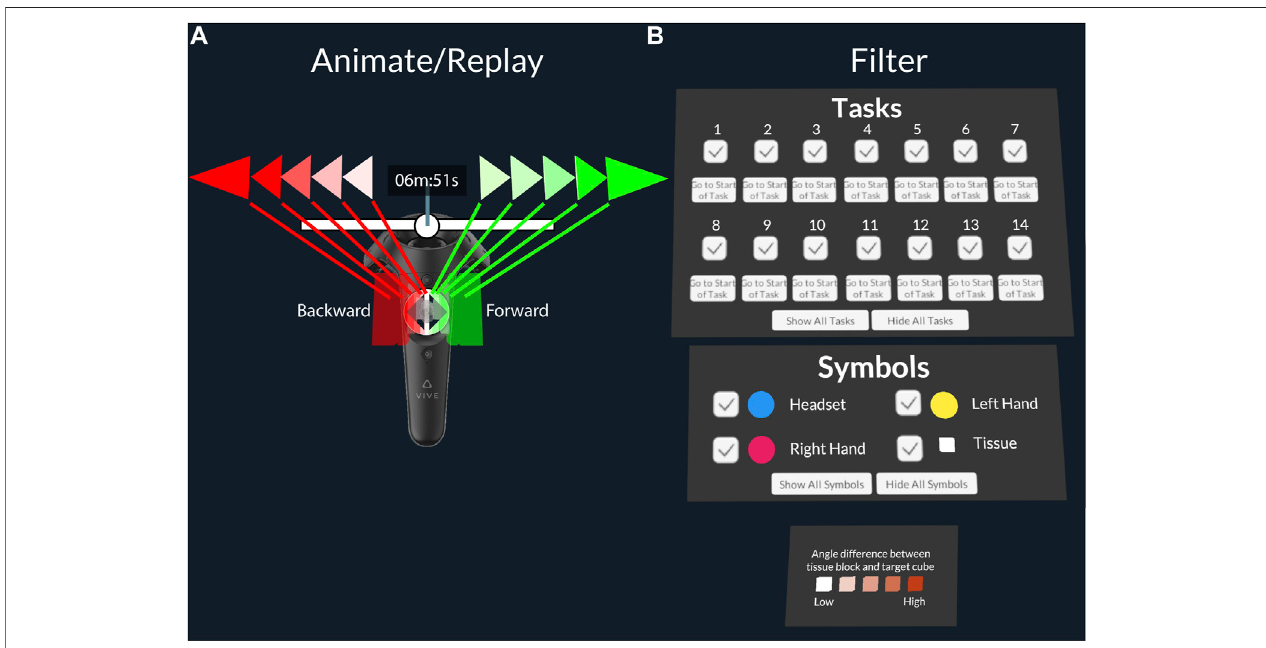
FIGURE 3 | (A) : Close-up of the left controller with play head speed zones. (B) : Filter menu to turn parts of the data overlay on and off by task number or graphic symbol type.